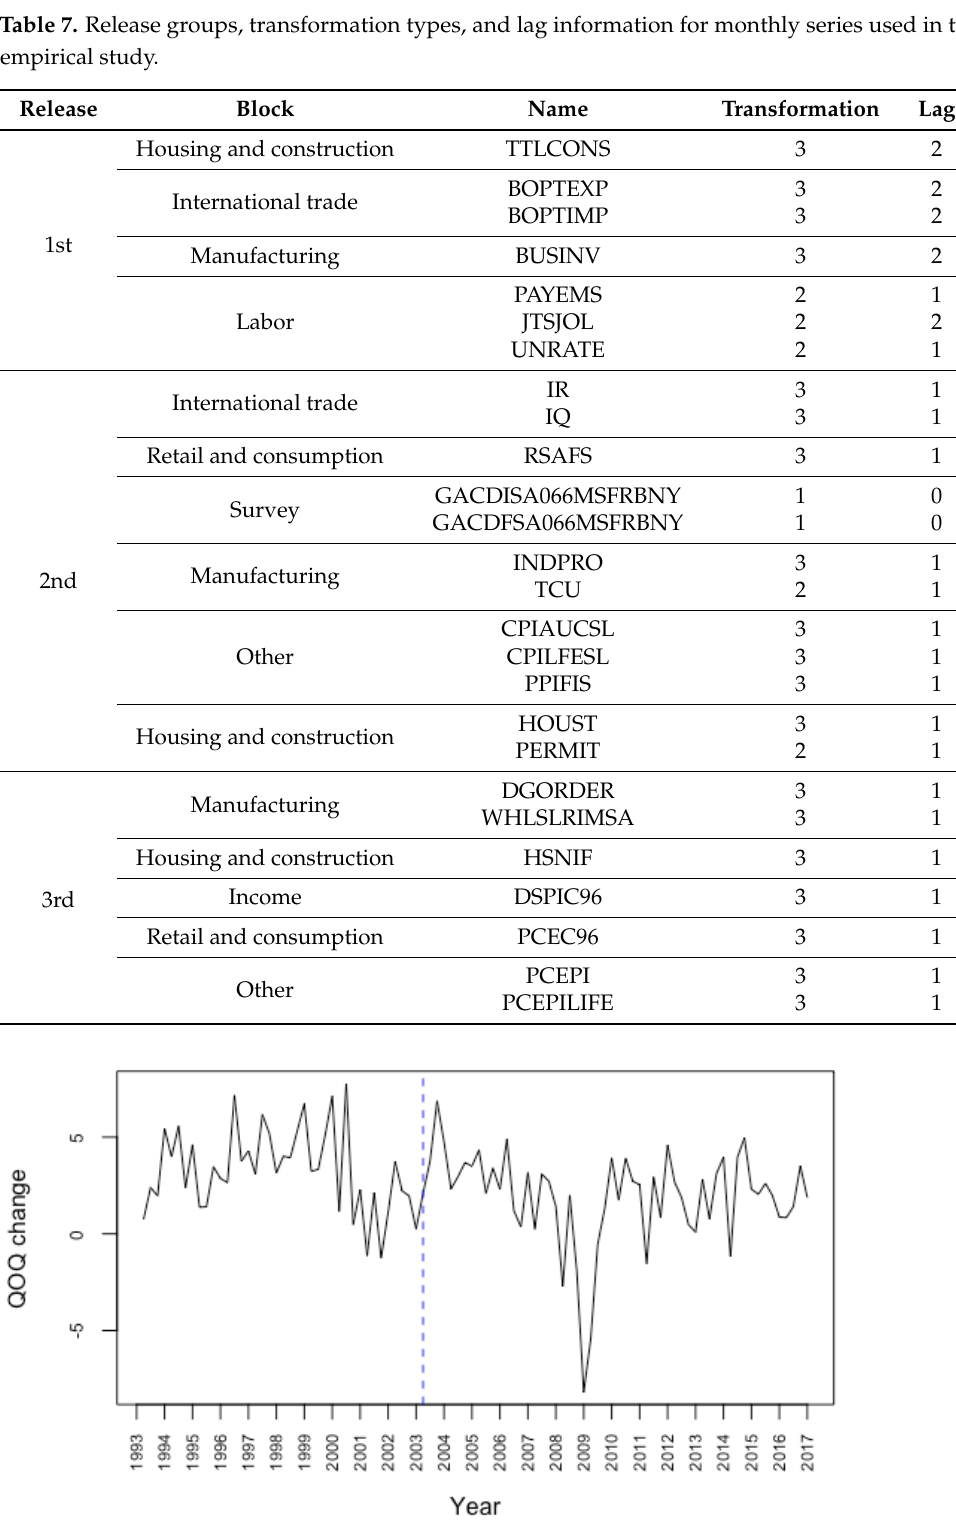
Figure 7. Real U.S. GDP growth rate from 1993Q1 to 2016Q4. Period after 2003Q1 (after blue dashed line) is the nowcasting